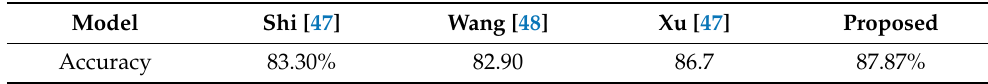
Table 3. Comparison of the proposed model with other state-of-the-art methods.